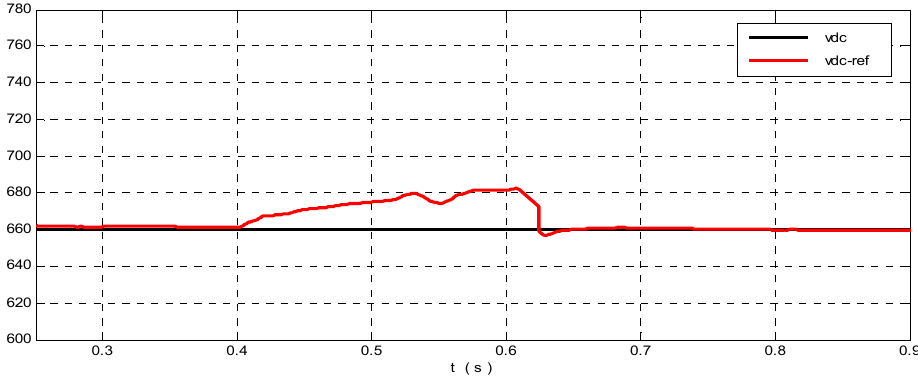
Figure 18. Simulation of the DC-bus voltage.